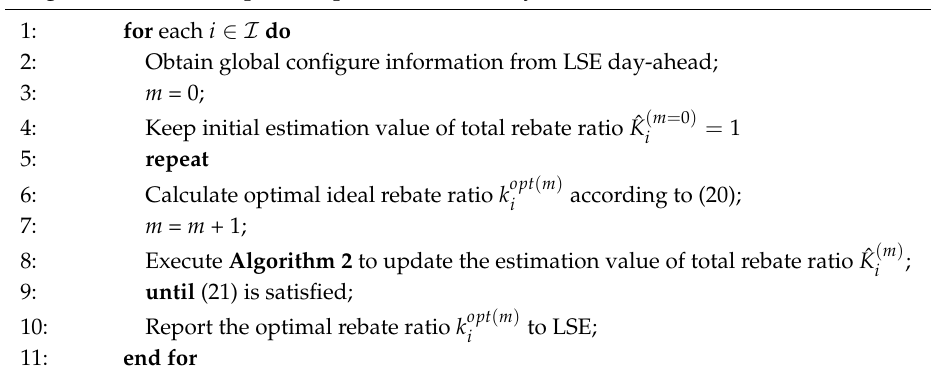
Algorithm 1: Non-cooperative process executed by DR customer i ∈